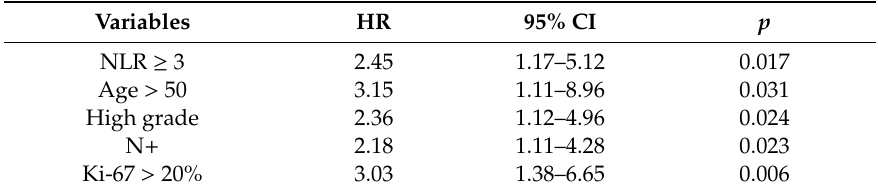
Table 2. Cox proportional hazard regression analysis for the association between NLR, clinical predictor variables, and PFS.